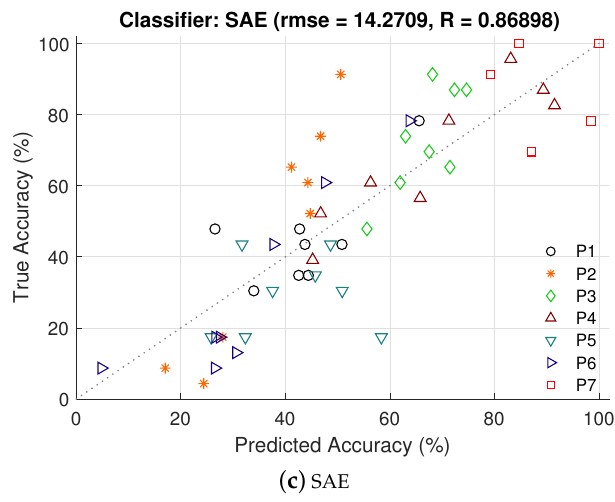
Figure 4. Predicted BCI accuracy from vCBLE are plotted against true accuracy for three different classifiers. P1, P2, P3, P4, P5, P6, and P7 are indicating each